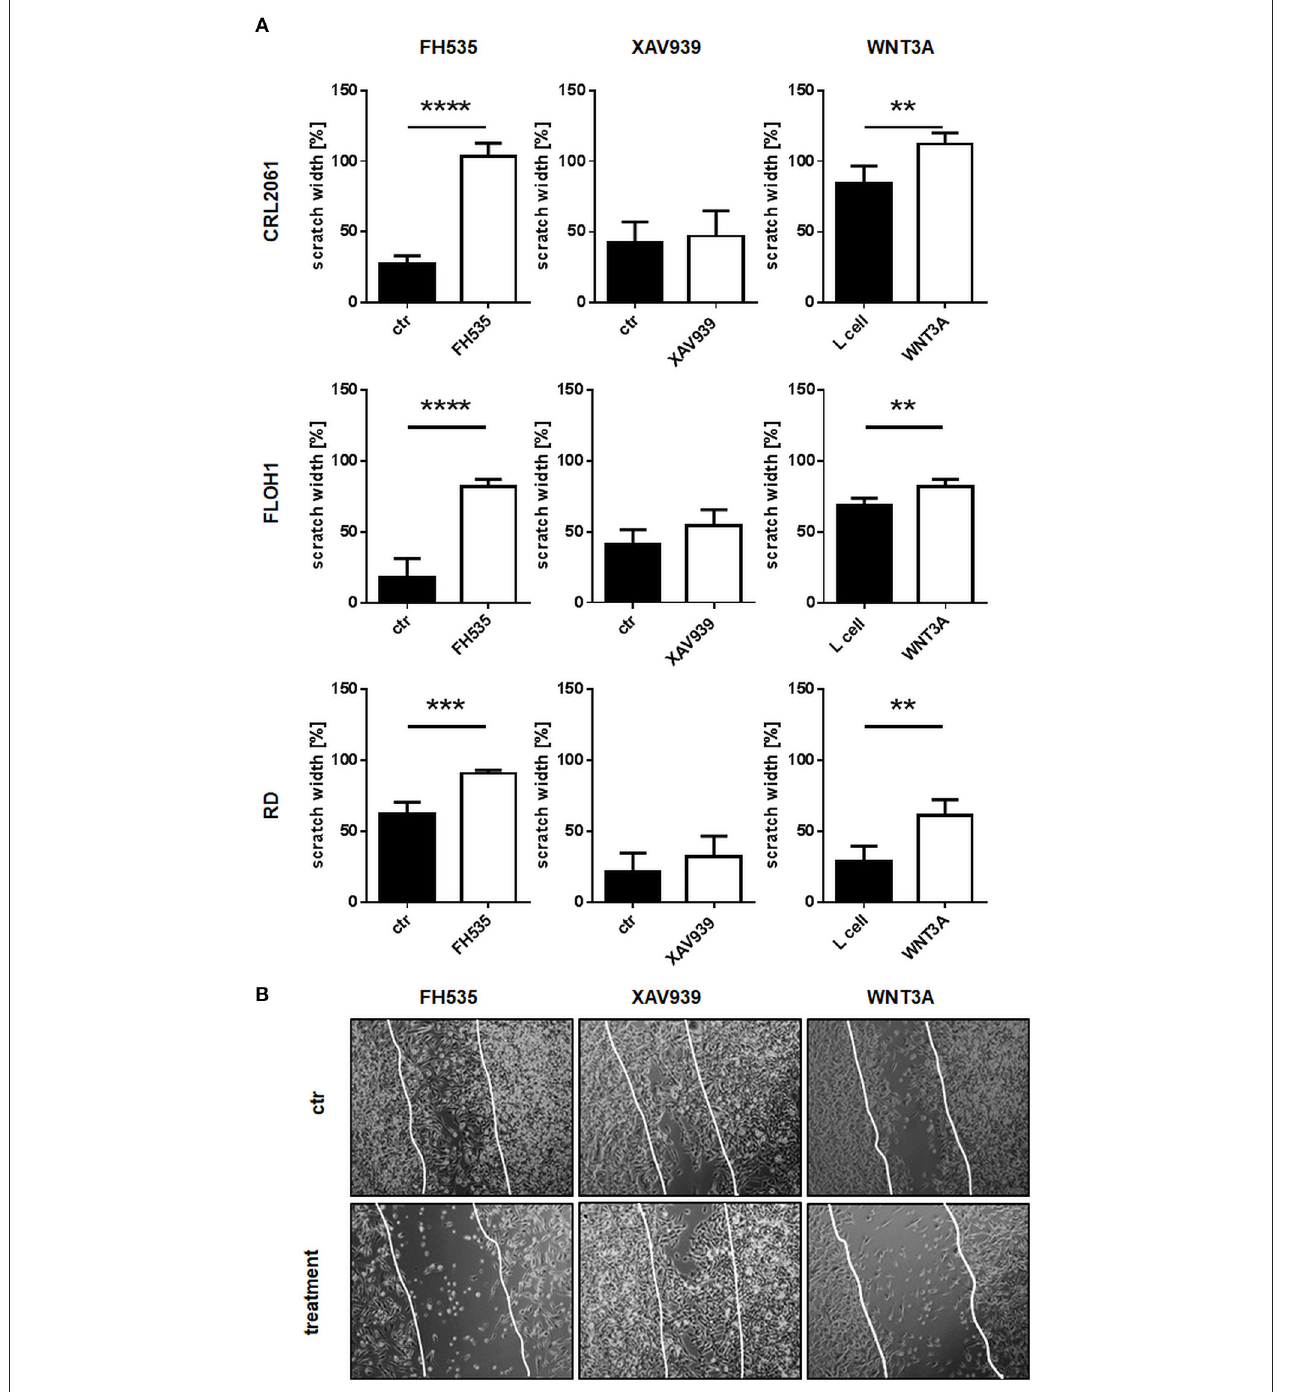
FIGURE 5 | Effects of FH535, XAV939, ß-catenin siRNA, or WNT3A on migration of RMS cell lines. (A) RMS tumor cells were pre-treated with FH535, XAV939, or WNT3A for 24h before making the scratch. Scratch width of untreated controls at time zero was set to 100%. After 0, 4, 8, 12, and 24 h scratch width was measured at four different positions. The graphs show the mean and SEM after 24h treatment. (B) Pictures of the scratch in control and treated RD cells after 24h using phase contrast with a magnification of 100x. Significance level: ** p < 0.01, *** p < 0.001, **** p < 0.0001.